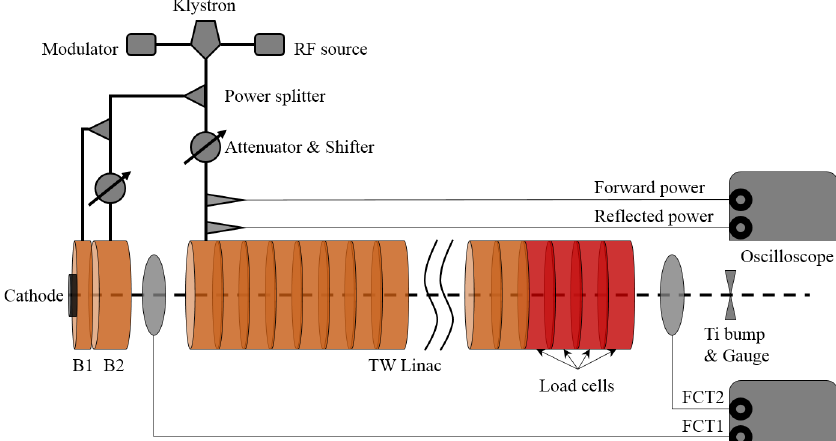
tightly.FIG. 1. Schematic view of the rf system and some key rf diagnostic instruments in the HUST compact THz-FEL prototype. B1 and B2 are the two standing wave